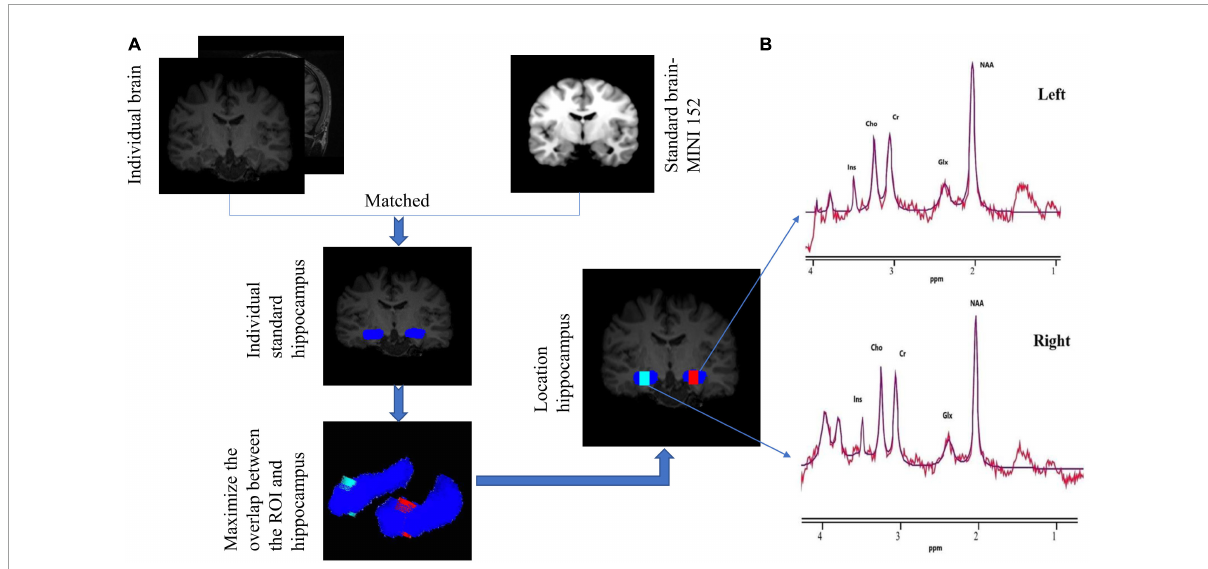
FIGURE2 (A) Flow chart of the MRI data processing procedure. The blue part represents the bilateral hippocampus of the individual. The voxel box has the largest overlap rate with the left hippocampus (red) and the right hippocampus (green). Coronal individual images showing the size (in voxels) and the location of the left (red) and right (green) hippocampus. (B) 1H-MRS obtained from the voxels at the individual level (red line) and the overlay of the spectral fit (purple line). All spectral data are analyzed with jMRUI version 5.2. NAA, N-acetyl-aspartate; Cho, phosphocholine and glycerophosphocholine; Cr, creatine and phosphocreatine; Glx, glutamate and glutamine; Ins, myo-inositol; ppm, parts per million.